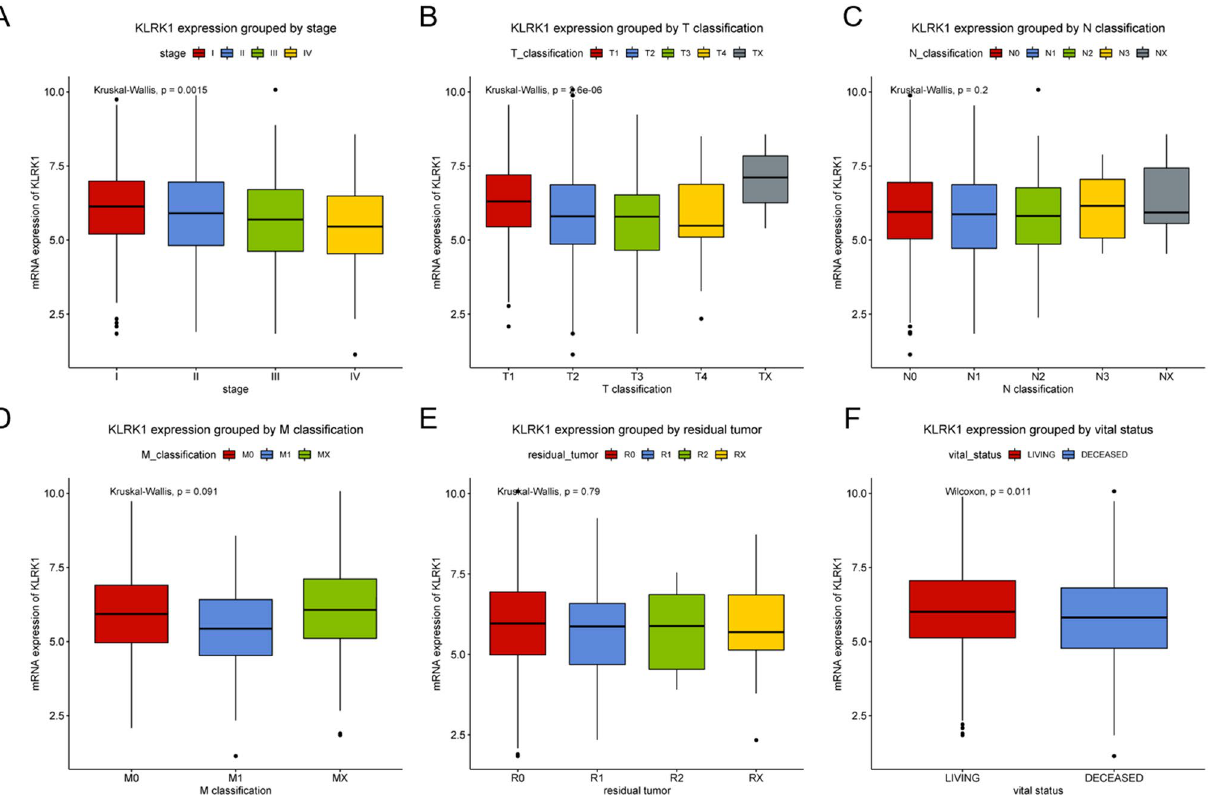
Figure 2. KLRK1 expression in lung cancer. Expression of KLRK1 grouped by ( A ) stage, ( B ) T classification, ( C ) N classification, ( D ) M classification, ( E ) residual tumor and ( F ) vital